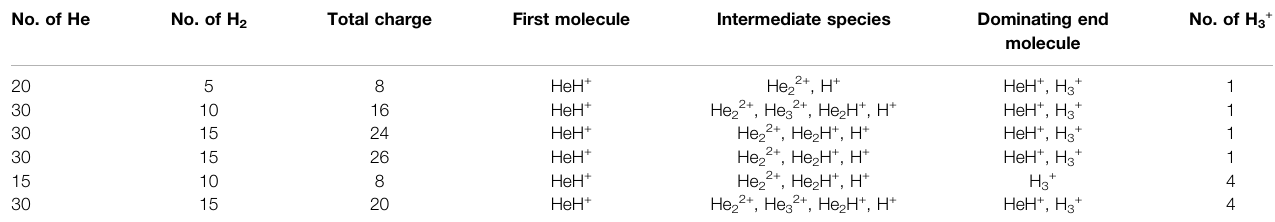
TABLE 6 | Different ratios of He to dihydrogen while varying the total positive charge of the system. No. of He